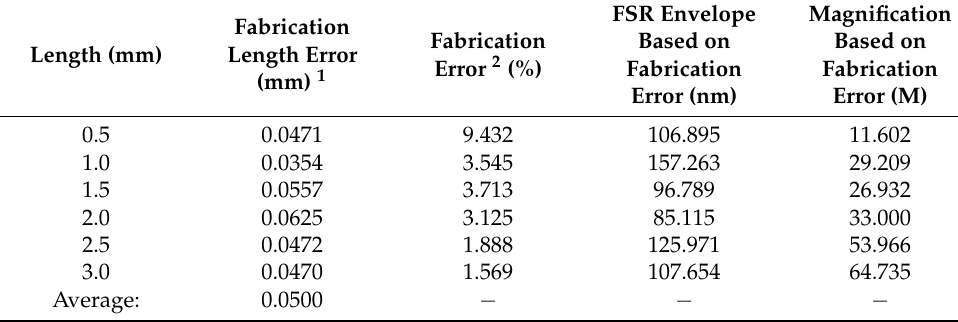
Figure 10. ( a ) Experimental setup for testing the transmission of the MZIs, ( b ) The transmission spectra of the sensing and reference MZIs at a reference temperature of 30 °C. Table 4. Fabrication error of each length.